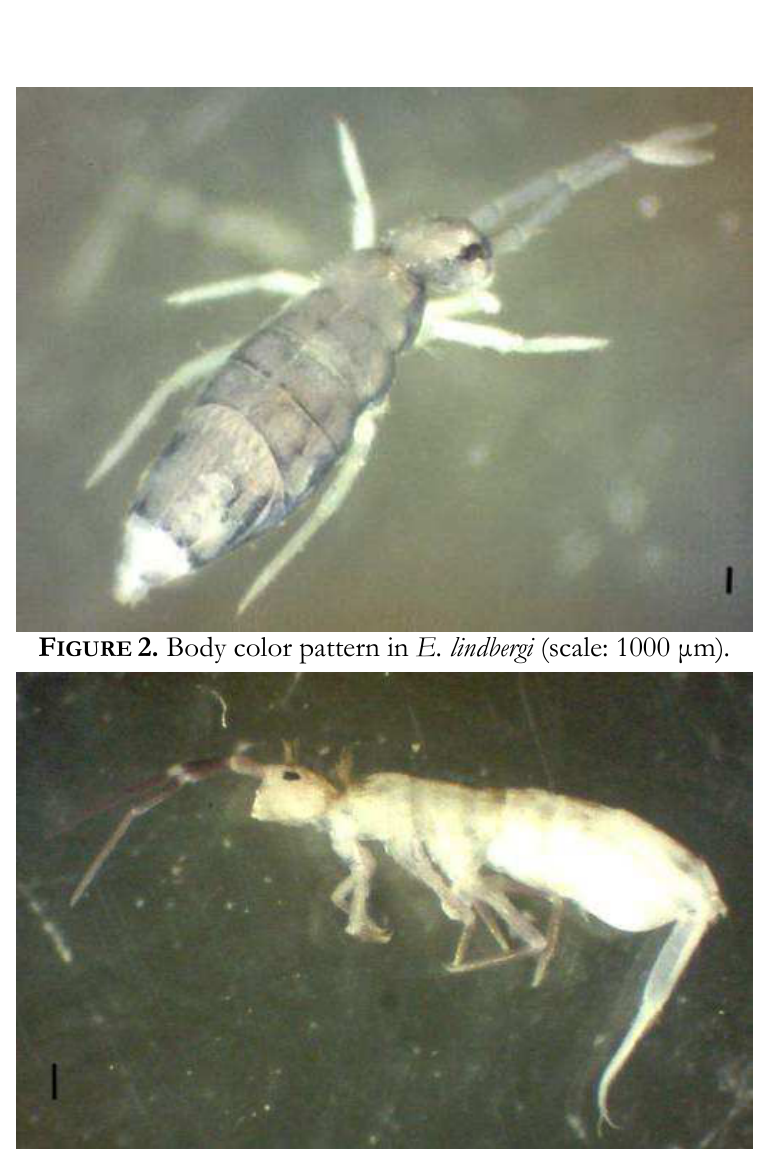
F IGURE 3. H. major with pigmented antenna (scale: 1000